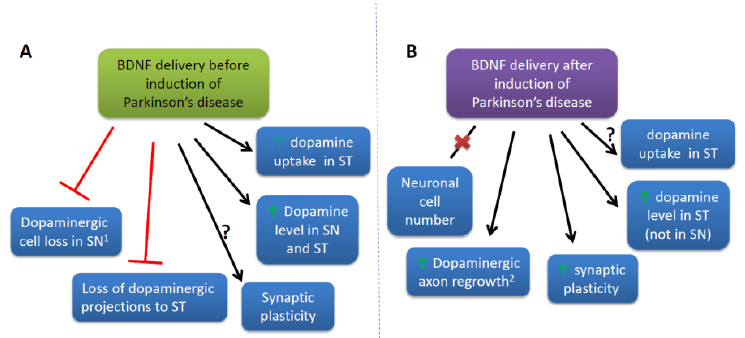
Figure 2. Summary of the major effects of BDNF delivery through direct injection and gene